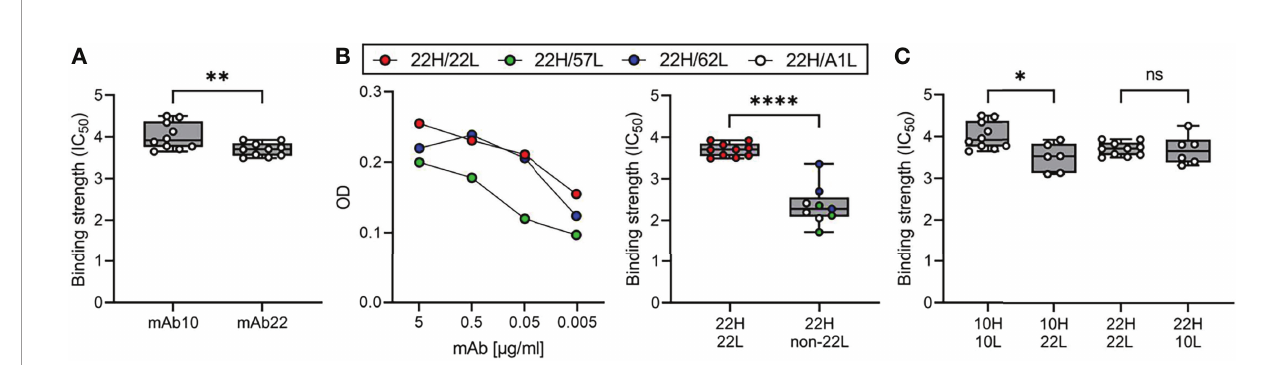
FIGURE 7 | Binding af fi nity of mAb10 and mAb22 to PfMSP1 3D7 . (A) The binding strength of mAb10 and mAb22 as determined by chaotropic ELISA. Binding strength (IC 50 ) is de fi ned as the concentration of urea that results in loss of 50% of mAb binding. A total of 10 replicates from three independent experiments are shown. Differences were tested for statistical signi fi cance using the Wilcoxon matched-pairs signed rank test, with pairs were de fi ned as antibodies analyzed on the same plate. (B) The binding of mAb22 and antibodies that consisted of the heavy chain of mAb22 and a light chain of an unrelated, non-MSP1-reactive antibody to PfMSP1 3D7 by regular ELISA (left) and chaotropic ELISA (right). Differences in binding strength between replicates of mAb22 (n = 10) and chimeric antibodies (n = 9, three replicates for each of three unrelated light chains that were combined for analysis) were tested for statistical signi fi cance using the Mann Whitney test. (C) The binding strength of mAb10 and mAb22 (n = 10 replicates each) expressed with their own light chains or chimeric mAbs in which the light chains were swapped (n = 6 replicates each). In all panels, data points are the average of three technical replicates. Differences between antibodies with the same heavy chain but a different light chain were tested for statistical signi fi cance using a Kruskal-Wallis test, followed by comparisons between select groups using Dunn ’ s post-hoc test, corrected for multiple comparisons. ****P < 0.0001; **P < 0.01; *P < 0.05; ns, not signi fi